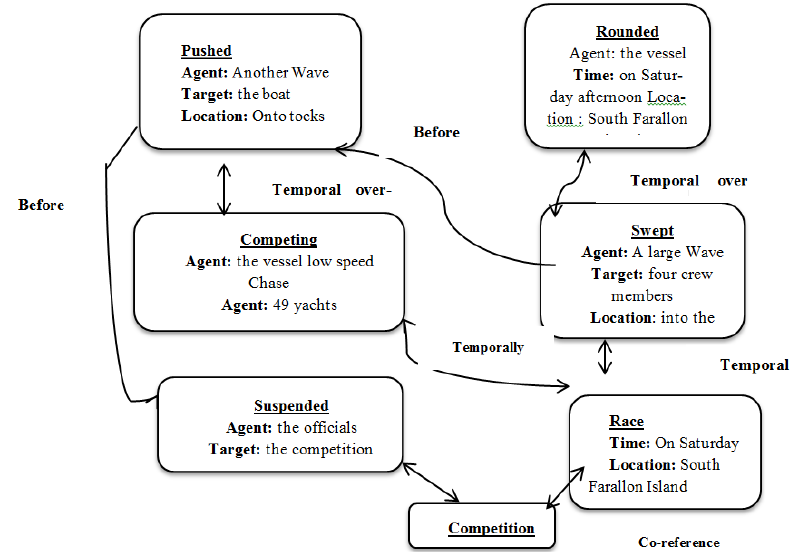
Fig. 3. Example Reference event graph from a news story from news